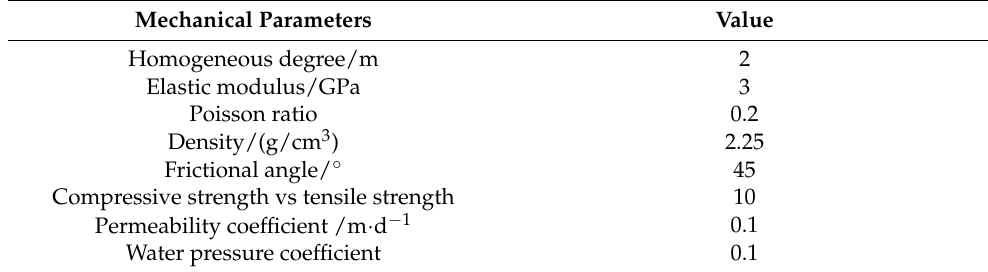
Table 2. Mechanical parameters of rock specimens.